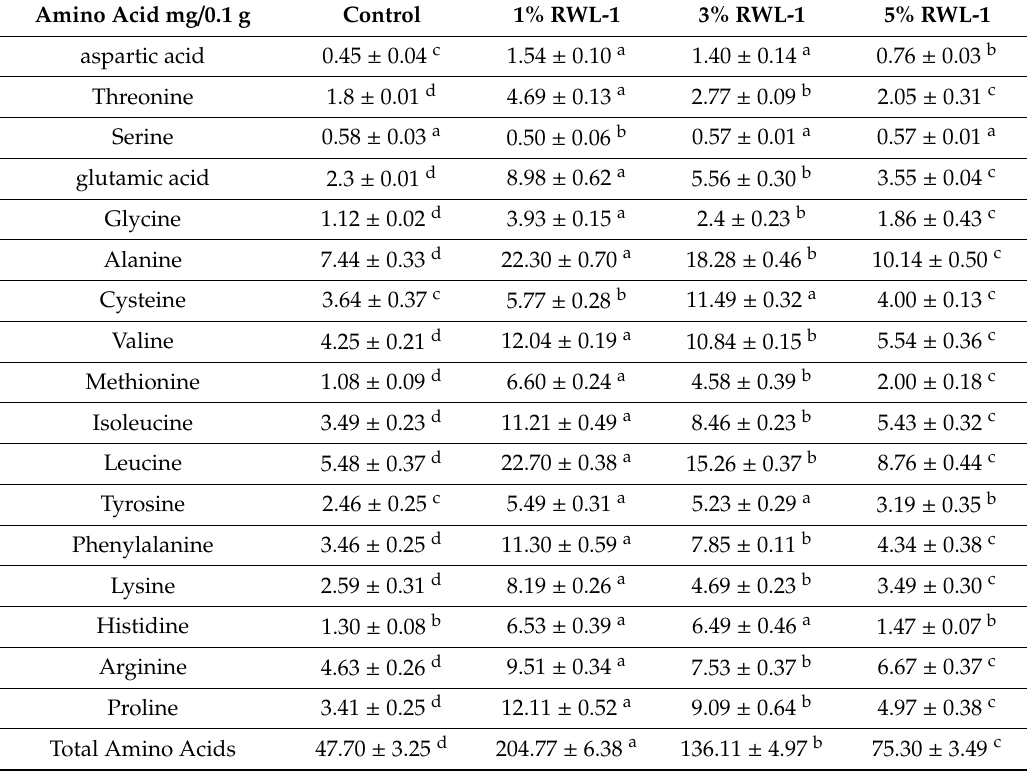
Table 1. Amino acids contents in non-fermented and fermented soybean with various concentrations (1%, 3%, and 5%) of B. amyloliquefaciens RWL-1. Amino Acid mg / 0.1